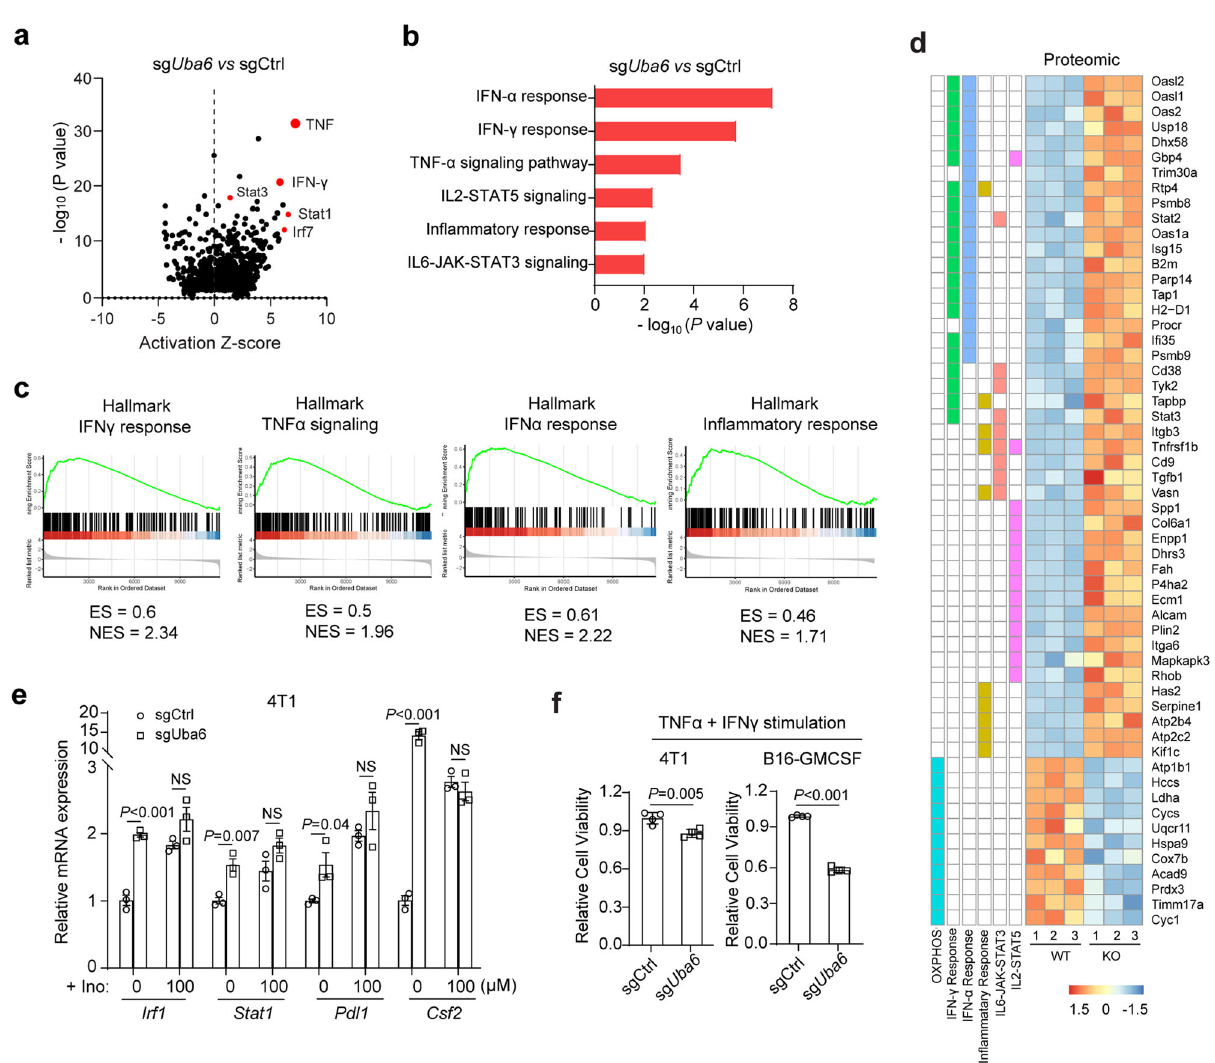
Fig. 4 | Inosine and genetic inhibition of UBA6 stimulate tumour cell-intrinsic immune response signalling. a Volcano plots of upstream regulator analysis of UBA6-dependent genes in 4T1 tumour cells by IPA. b Top-ranked GO terms in the transcriptomeof Uba6 -null4T1tumourcells. c TheupregulatedGSEAsignaturesin the Uba6 -null 4T1 tumour. d Heat-map of proteins for differential signalling path- ways (Red upregulated, blue downregulated). The expression level of these pro- teins in sgCtrl and sg Uba6 4T1 cells is measured by the whole proteomics ( n =3). e The relative mRNA expression of IFN γ response-related genes in sgCtrl and